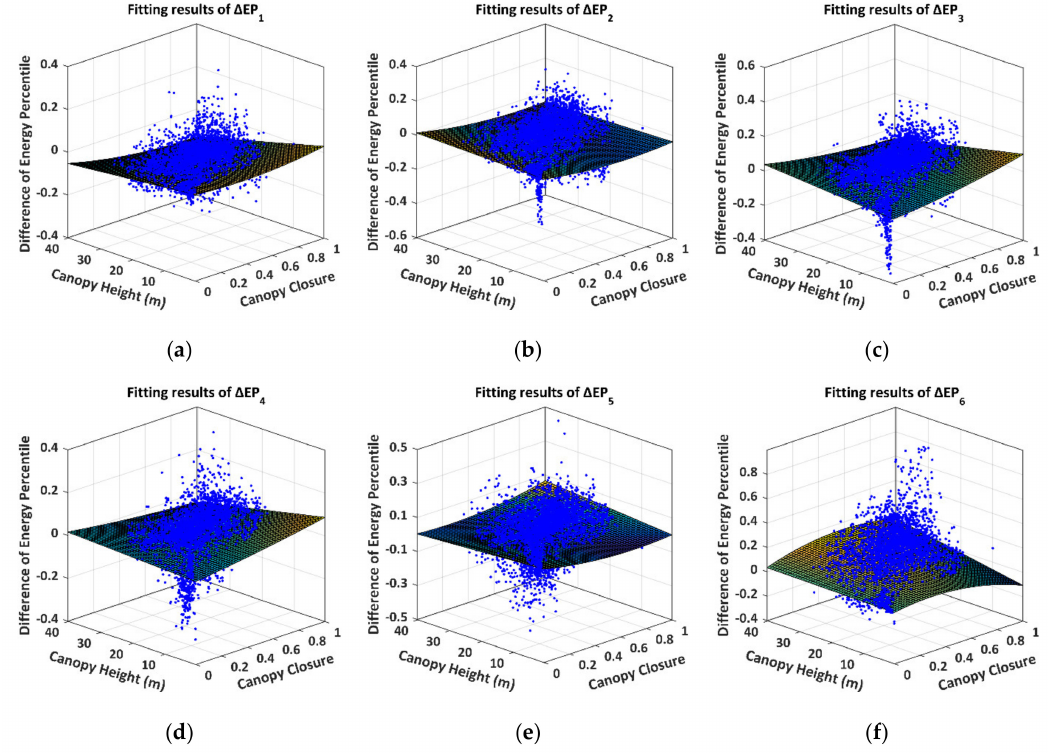
Figure 13. The fitting curved surfaces of the DEP. The blue dots and the curved surfaces represent the DEP distributions and the fitting surfaces at different energy percentiles, respectively. ( a ) ∆ EP 1 ; ( b ) ∆ EP 2 ; ( c ) ∆ EP 3 ; ( d ) ∆ EP 4 ; ( e ) ∆ EP 5 ; ( f ) ∆ EP 6